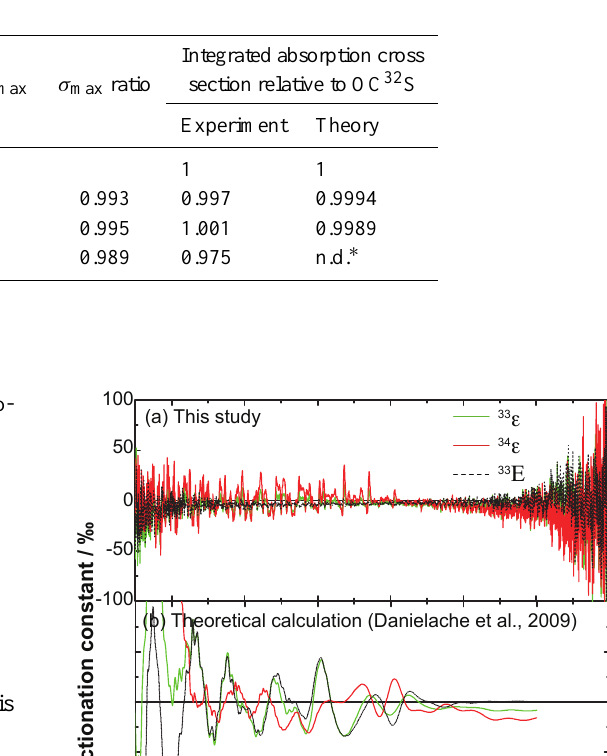
Table 1. Wavelength at σ max , shifting of σ max , σ max ratio for each isotopologue, and the ratio of the areas under spectral curve for the measured spectra (195–260nm). All comparisons are relative to OC 32 S.